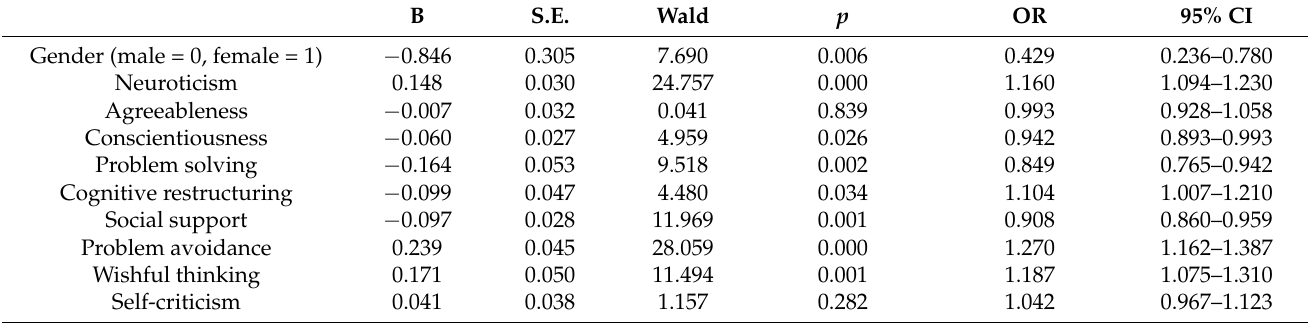
Table 3. Results of the logistic regression analysis with compulsive buying as dependent variable.